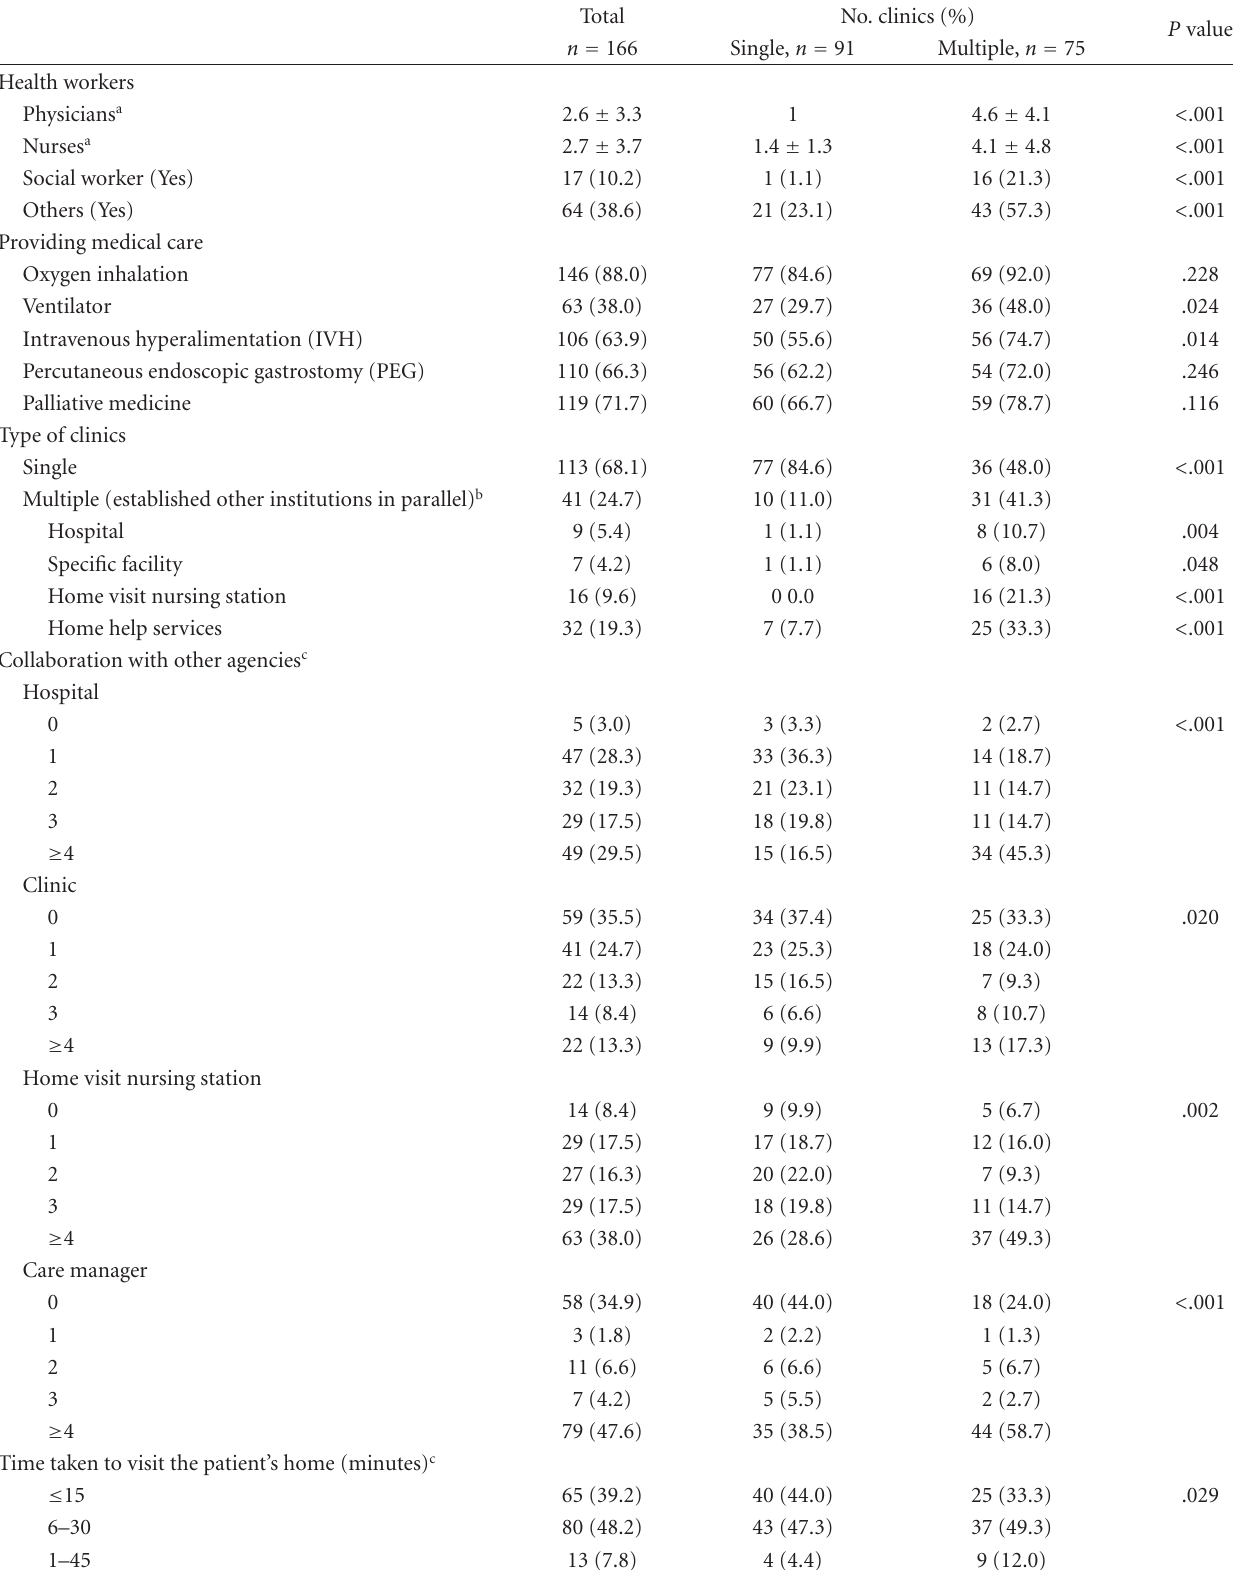
Table 1: Characteristic of the